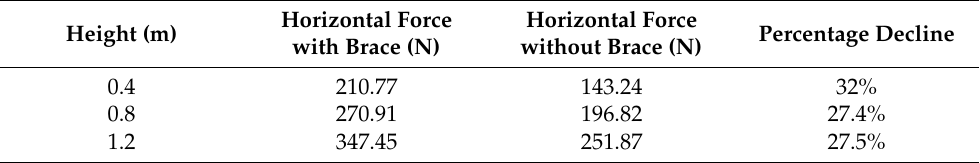
Figure 4. Von Mises stress distribution of the inferior articular surface of the tibia in braced (right) and unbraced (left) conditions at ( a ) 0.4 m, ( b ) 0.8 m, and ( c ) 1.2 m. The average horizontal forces on the talus are shown in Table 1. Before wearing the brace, the average horizontal forces were 210.77 N, 270.91 N, and 347.45 N with increasing jump height. After wearing the brace, the average horizontal forces corresponding to the three heights decreased by 32%, 27.4%, and 27.5%, respectively, to 143.24 N, 196.82 N, and 251.87 N. Table 1. The average horizontal forces on the talus with and without the brace at 0.4 m, 0.8 m, and 1.2